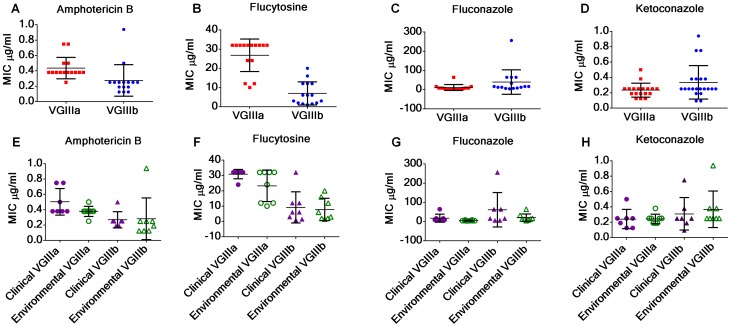

C. gattii VGIIIb isolates display higher antifungal susceptibility values to Amphotericin B and flucytosine in contrast to VGIIIa isolates.(A, E) MIC of VGIIIa (red) versus VGIIIb (blue) for amphotericin B (A), flucytosine (B), fluconazole (C), and ketoconazole (D). MIC of clinical (purple) and environmental (green) isolates of VGIIIa (triangles) and VGIIIb (circles). The MIC of VGIIIa isolates was significantly higher than VGIIIb isolates for amphotericin B (p = 0.0178) and flucytosine (p<0.0001) but not for fluconazole (p = 0.1059) or ketoconazole (p = 0.0685). No significant differences were observed between environmental and clinical isolates of VGIIIa or of VGIIIb in response to amphotericin B (E), flucytosine (F), fluconazole (G), or ketoconazole (H) (Table S10a, S10b and S10c). MIC values, which exceeded the maximum concentration for each Etest, were assigned as the maximum concentration tested for averaging and graphing (Table S1). Maximum concentrations of Etest amphotericin B (32 µg/ml), fluconazole (256 µg/ml), flucytosine (32 µg/ml), and ketoconazole (32 µg/ml).